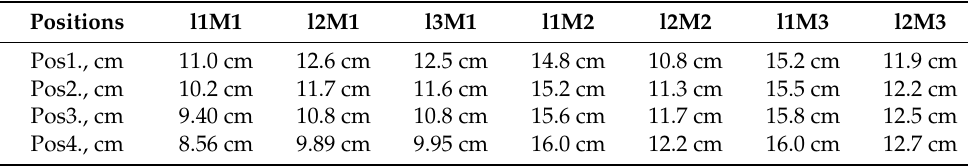
Table 4. Sensor measurements in four different positions.